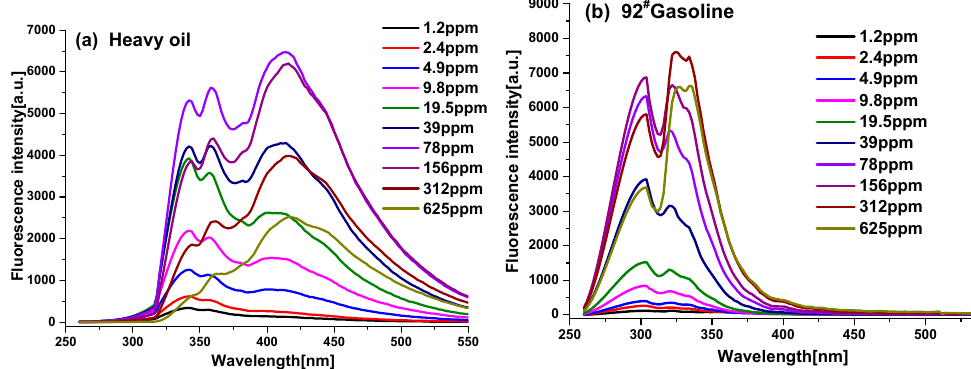
Figure 2. The emission spectra obtained from two kinds of oils in the concentrations range 1.2 ppm to 625 ppm in the excitation wavelength at 266 nm. ( a ) heavy oil; ( b ) 92 # gasoline.